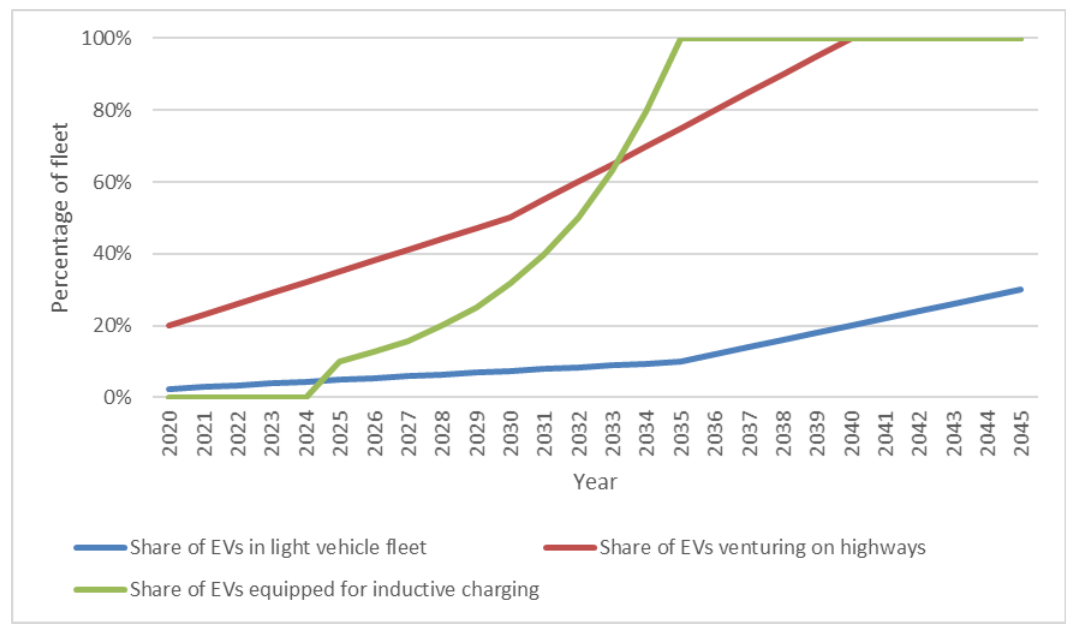
Figure 1. Hypotheses of electric vehicle (EV) penetration, the share of electric vehicles (EVs) venturing on highways, and the percentage of EVs equipped for inductive charging.